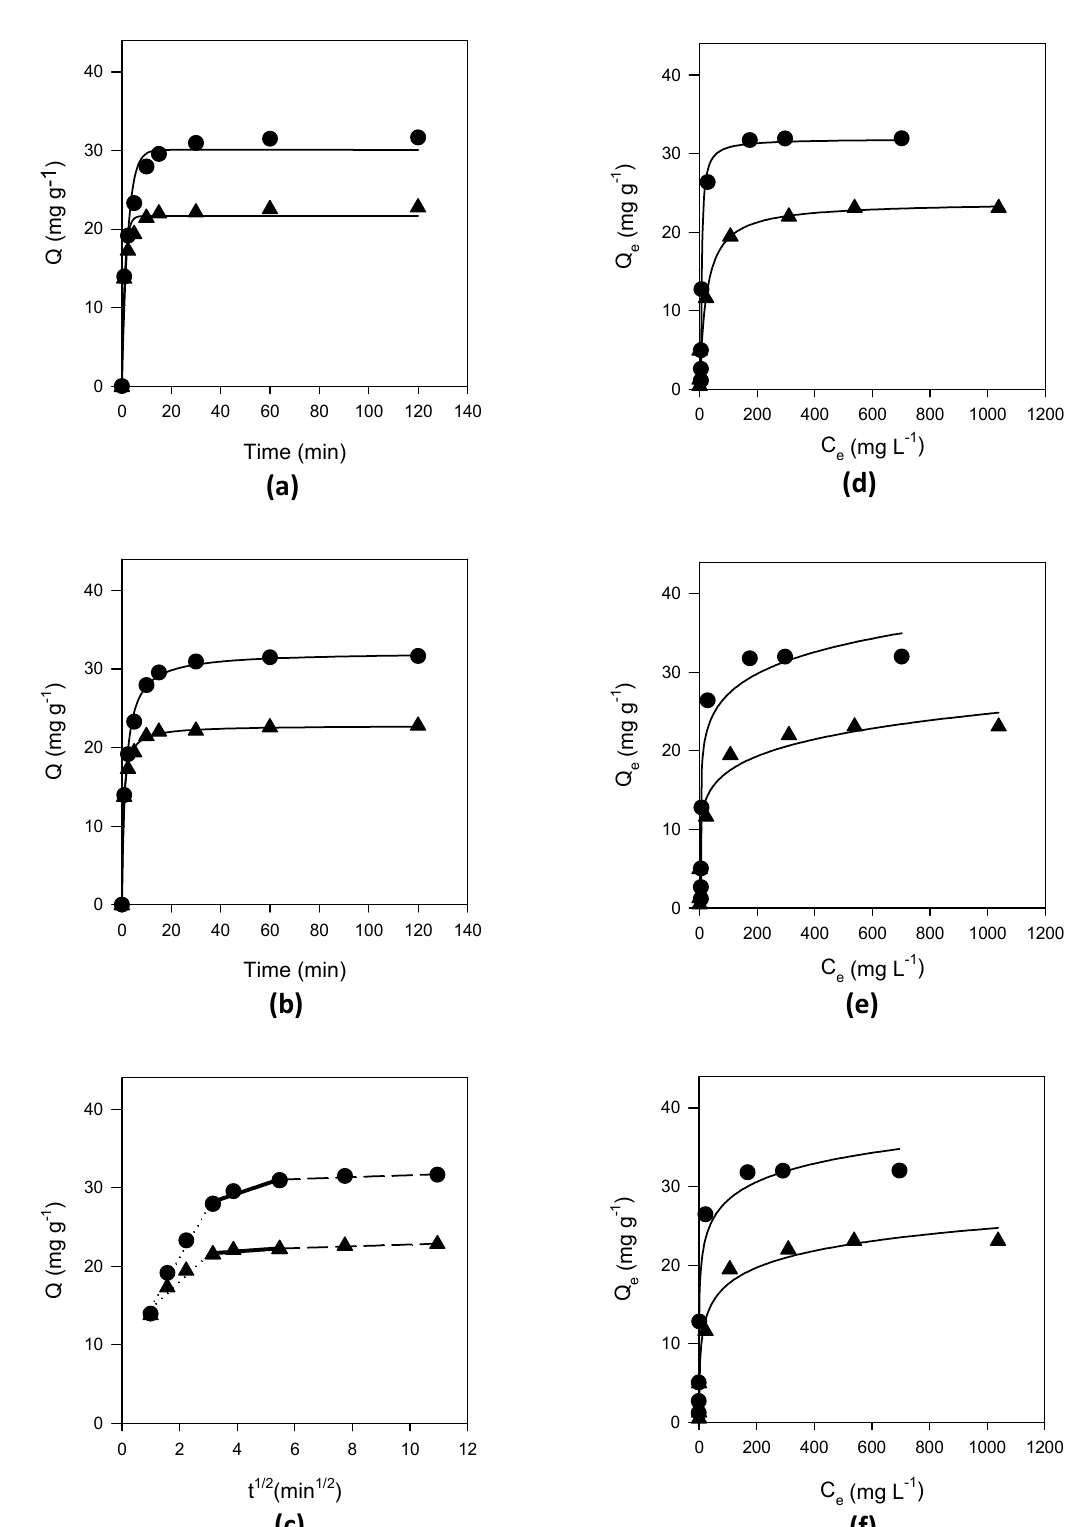
Figure 1. Adjustment of di ff erent models to the experimental data. Dots represent the plot of sepiolite data and triangles represent the plot of S-Fe data; ( a ) lines represent pseudo-first order model adjustments; ( b ) lines represent pseudo-second order model adjustments; ( c ) lines represent intra-particle di ff usion adjustments; ( d ) lines represent Langmuir model adjustments; ( e ) lines represent Freundlich model adjustments; ( f ) lines represent Temkin model adjustments.